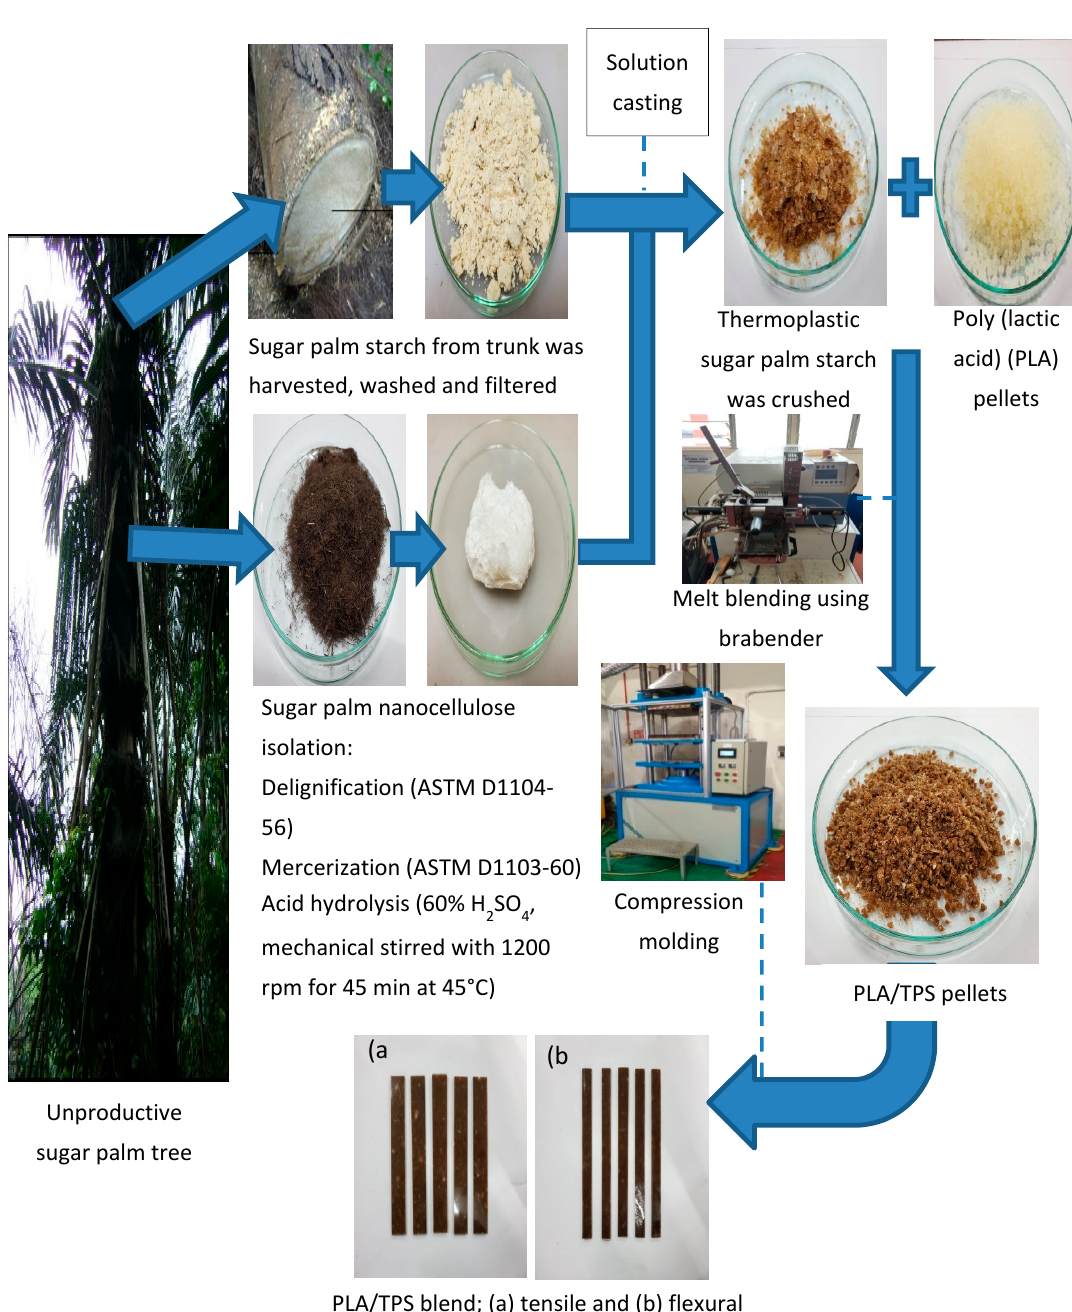
Figure 1. Thermoplastic starch (TPS) / poly (lactic acid) (PLA) blend bionanocomposite